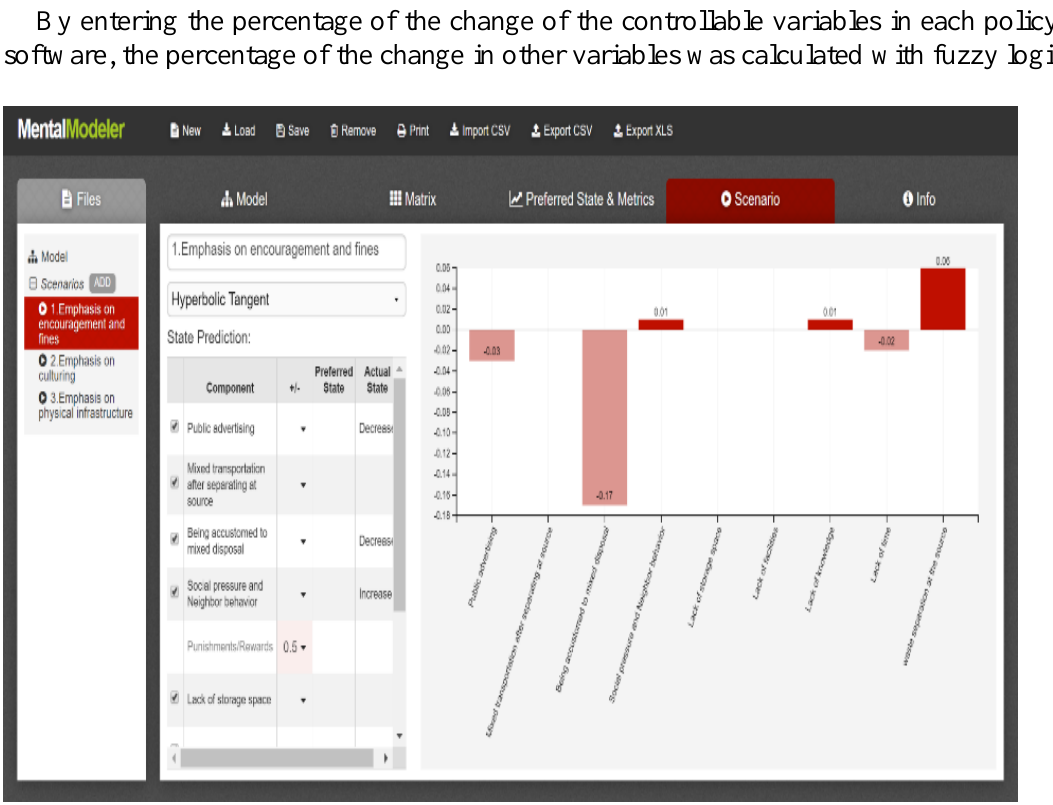
Figure 3. Variables sensitivity analysis in the mentalmodeler software After sensitivity analyzing in each of the policies, the percent change in the variables of the model was calculated as shown in Figure